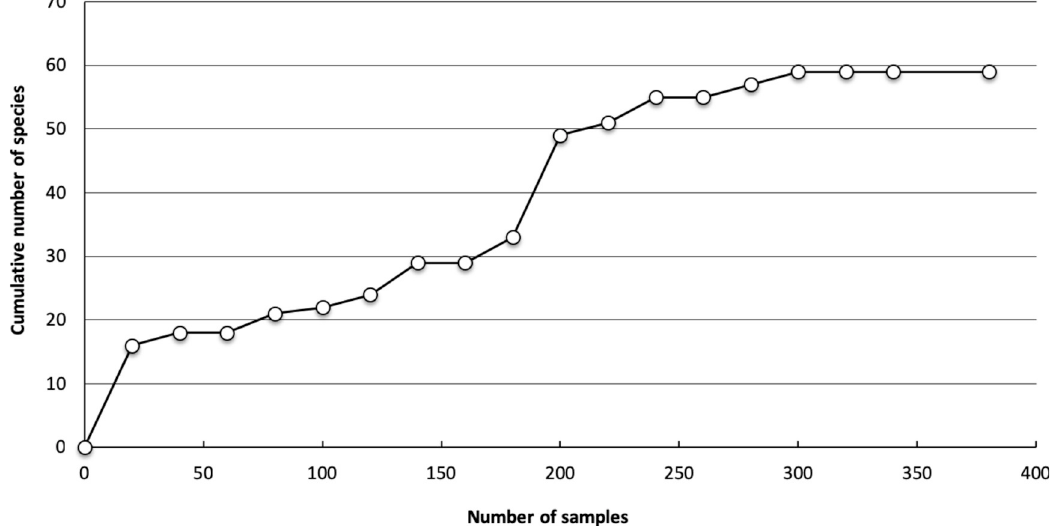
Fig 2. Species accumulation curve for the 58 of the 65 mosquito species (354 collections) collected in Nuevo Leo´n during 2006–2010. vegetation, such as water hyacinths, in a region of shrubs. Associated species were An . pseudo- punctipennis , An . quadrimaculatus , An . albimanus , Ae . scapularis , Ae . taeniorhynchus , Ps . ciliata , Cx . coronator , Cx . quinquefasciatus , Cx . erraticus , Ma . titillans , and Ur . lowii . Aedes ( Ochlerotatus ) trivittatus (Coquillett). Although Ae . trivittatus is widely distrib- uted in Mexico, this is the first record for Nuevo Leo´n state. Females were collected biting humans during the day in oak forest in La Camotera, Santiago County, in association with Ae . quadrivittatus , Ae . amateuri , Ae . brelandi , and Wyeomyia n. sp.; in an area of shrubs in Mina County in association with Ps . cyanescens ; and in caves in Lampazos del Naranjo County. Females were collected at night in Lagunita de Taberna, Mier y Noriega County; and in Cie´- nega de Gonza´lez, Santiago County, in association with Ae . amateuri , Ae . amabilis , Ae . triseria- tus / Ae . brelandi , Ps . ferox , Cs . particeps , and Ur . coatzacoalcos . Specimens were also collected at night in octenol-baited CDC light traps in Lagunita de Taberna; in a CDC light trap without bait in Cie´nega de Gonza´lez, in association with Ae . amabilis and Cs . particpes ; and in a CDC light trap without octenol located in a shrubby area in Las Labores del Ojo, Mina County, in association with An . pseudopunctipennis , Ps . columbiae , Ps . signipennis , and Ps . cyanescens . Aedes ( Protomacleaya ) amabilis Schick. The presence of Ae . amabilis in Nuevo Leo´n is the most unexpected record in this study. Since the species was originally described from females collected in Cueva del Nacimiento del Agua, Veracruz state, Mexico, by Schick [11], it has been recorded only in Tamaulipas state. Females were captured biting collectors at dusk in El Salto, Zaragoza County, and biting at night in Cie´nega de Gonza´lez, Santiago County. Asso- ciated species were Ae . amateuri , Ae . trivittatus , Ae . triseriatus / brelandi , Ps . ferox , and Cs . parti- ceps . Additional females were collected at night in CDC light traps in the latter location; associated species were Ae . trivittatus and Cs . particeps . All of the collection sites were in oak forest. No immature stages of Ae . amabilis were collected. Haemagogus ( Haemagogus ) equinus Theobald. The genus Haemagogus , subgenus Hae- magogus , and Hg . equinus are recorded for the first time in Nuevo Leo´n. Females were col- lected in only one location in Belisario Domı´nguez, Linares County, during the day in a region of shrubs in association with Ae . aegypti , Ae . albopictus , and Ps . ferox .